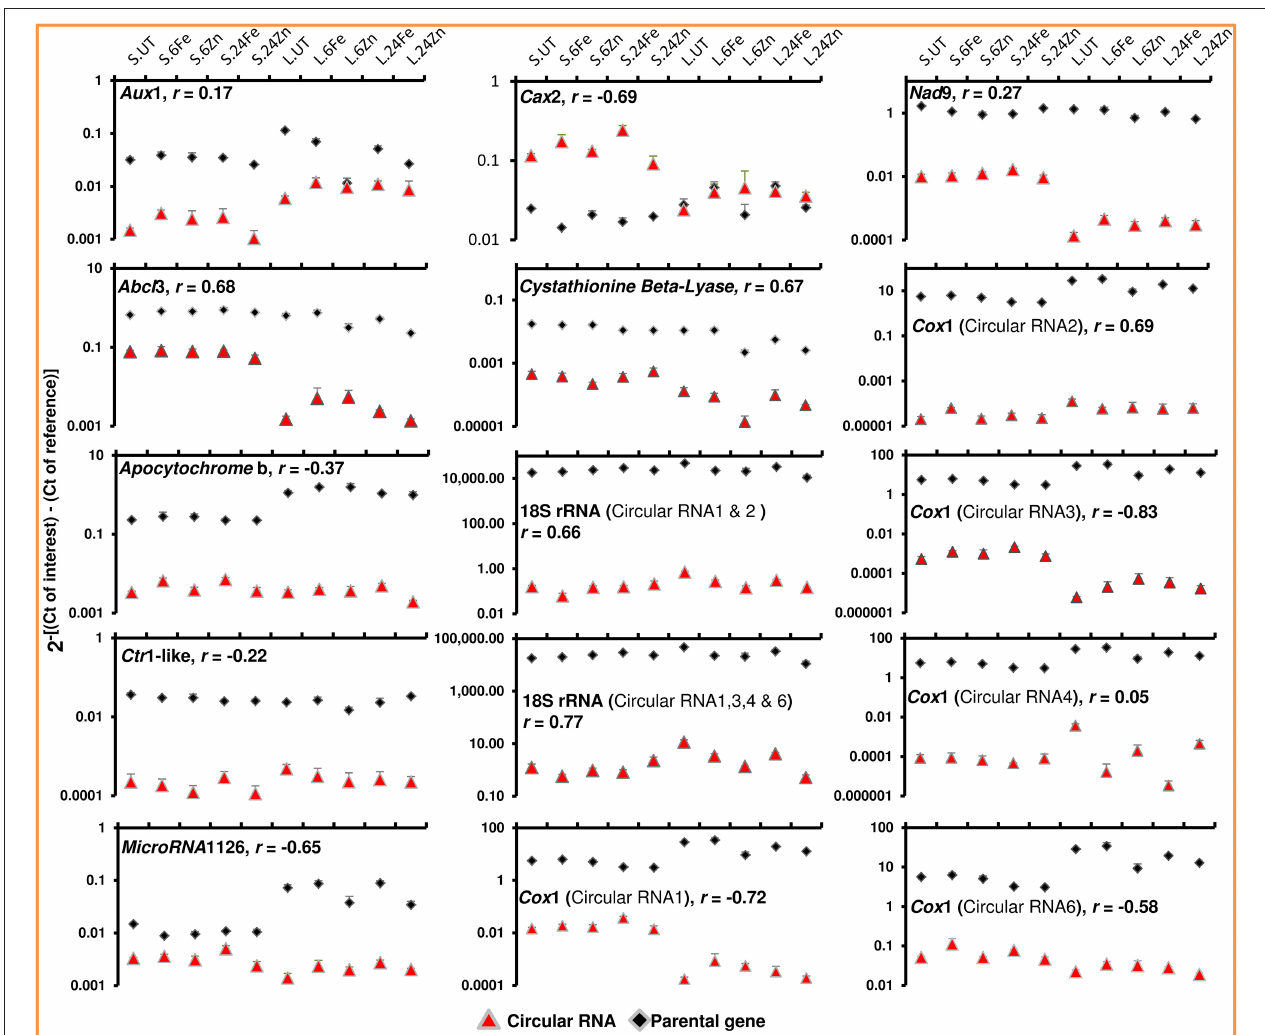
FIGURE 3 | The cellular levels of circular RNAs differ across tissues and in response to micronutrients and show in general no strong correlation with the linear-transcript expression of their parental genes. Real-time PCR was applied to target the circular RNA junctions and the parental genes using divergent and convergent primer pairs, respectively. Error bars represent the standard deviations for three technical replicates. Three biological replicates for each sample were pooled in the experiment. Seed and leaf samples are shown as S and L. UT, Fe, and Zn are for untreated, iron-treated, and zinc-treated plants. The samples of 6 and 24 h after treatments are represented by 6 and 24. The Pearson correlations ( r ) between circular RNAs and their parental genes were measured on log 2 transformed data. See Table 1 for full name of the genes. CT, the cycle threshold of amplified fragments.